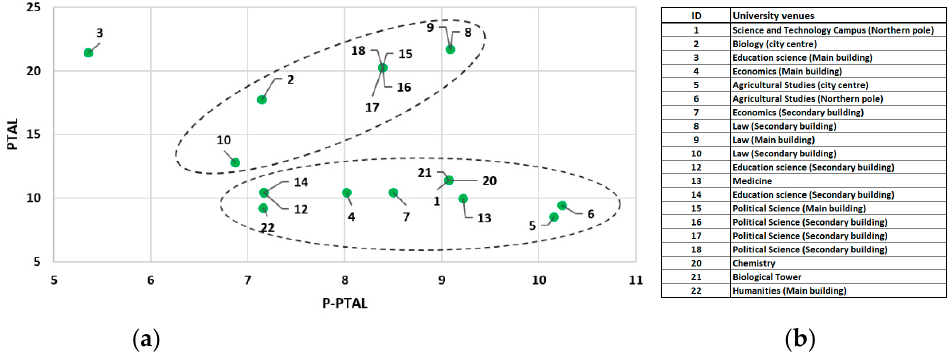
Figure 6. ( a )Active (PTAL) and Passive PTAL (PPTAL) for different university destinations (adimensional); ( b ) codes used for each university venue.